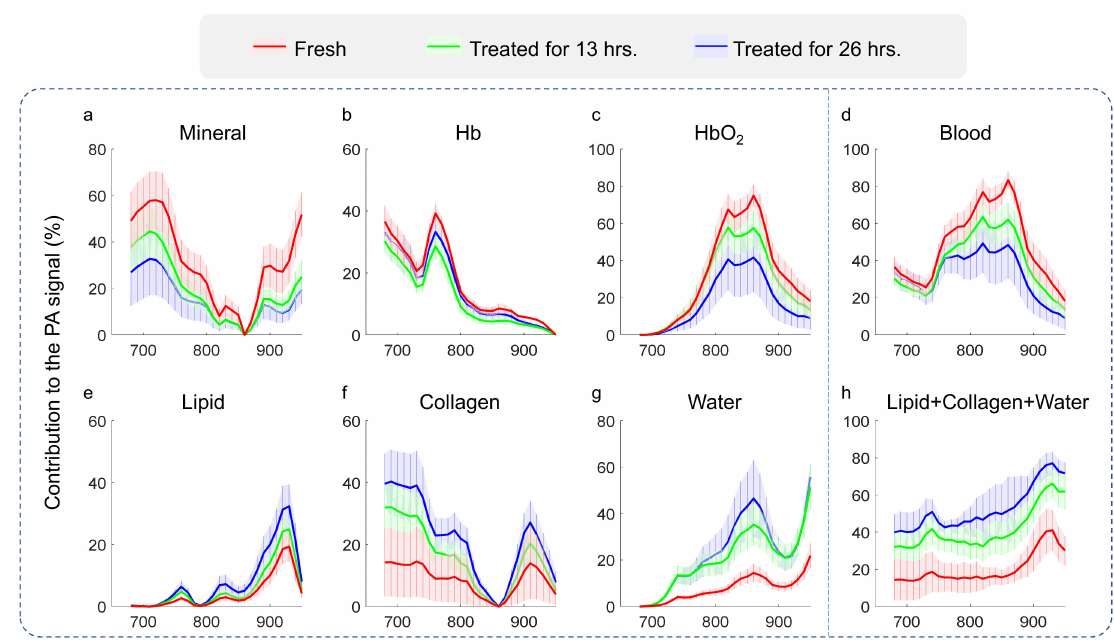
Figure 5. The contributions of each optically absorbing chemical component to the PA absorption curves, including ( a ) hydroxyapatite, ( b ) deoxygenated hemoglobin (Hb), ( c ) oxygenated hemoglobin (HbO 2 ), ( d ) whole blood (Hb + HbO 2 ), ( e ) lipid, ( f ) collagen, ( g ) water, ( h ) and the total of lipid, collagen, and water, to the bone PA signals at di ff erent optical wavelengths from 680 nm to 950